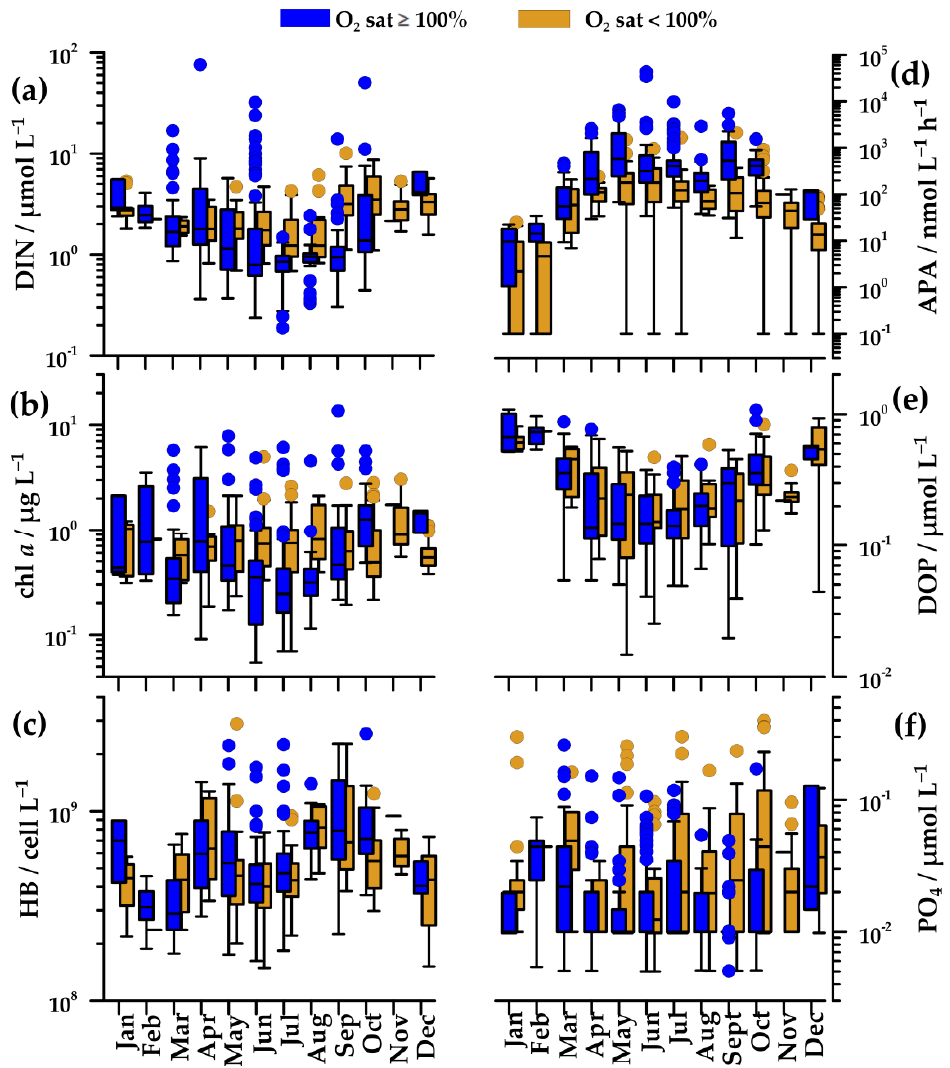
Figure 4. Annual cycles of ( a ) dissolved inorganic nitrogen (DIN), ( b ) chlorophyll a (chl a ), ( c ) heterotrophic bacteria (HB), ( d ) alkaline phosphatase activity (APA), (e) dissolved organic phosphorus (DOP), and ( f ) orthophosphate (PO 4 ) in oxygen ‐ saturated (blue squares) and oxygen ‐ undersaturated waters (golden squares) in the Northern Adriatic during 2004–2013. Plot characteristics are reported in Figure 2.